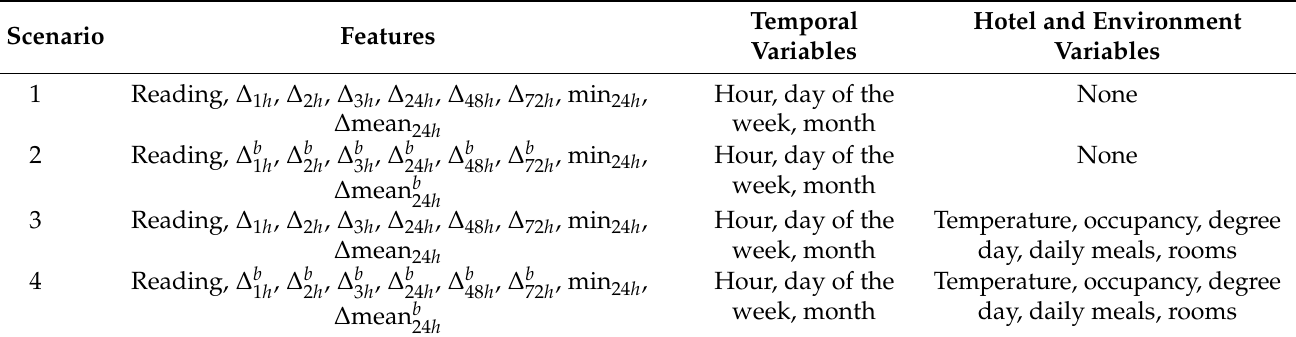
Table 4. Different sets of input variables of the algorithms used in the